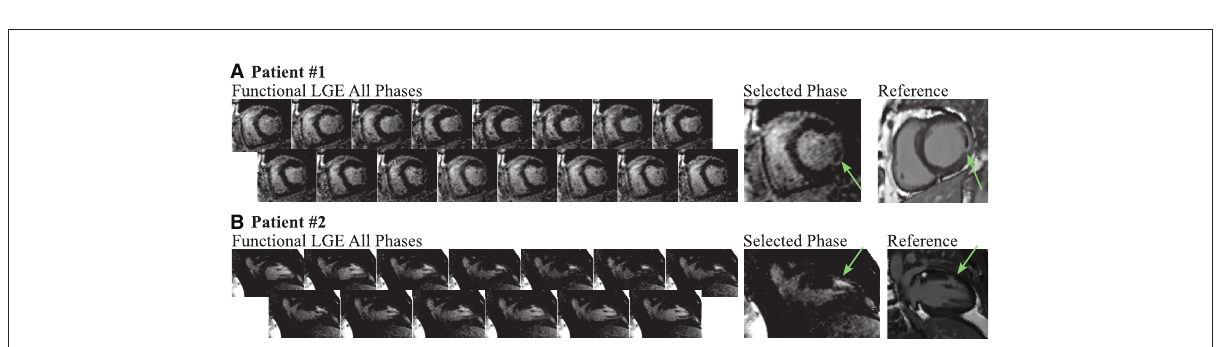
FIGURE7 Functional LGE images acquired in two patients at 3T compared to high-resolution reference LGE images. (A) Lateral scar (green arrows) is observed in a 73 old woman (heart rate 57 bpm, acquisition phases 16), referred to CMR for evaluation of myocarditis and perfusion defects. The scar tissue is visible in all cardiac phases of the functional LGE scan acquired at 60 ms temporal resolution, albeit variations in the noise levels across the cardiac cycle can be observed. In comparison, the high-resolution reference LGE scan displays much better noise resilience and a finer depiction of the scar structure. (B) Two chamber acquisition in a 58 year-old man (heart rate 64 bpm, acquisition phases 13) referred to CMR for evaluation of coronary artery disease. The subendocardial scar (green arrows) can be seen in both the reference and the functional LGE images. Systolic phases of the latter visualize spatially and contrast the separation of the scar tissue from the nearby blood pool.